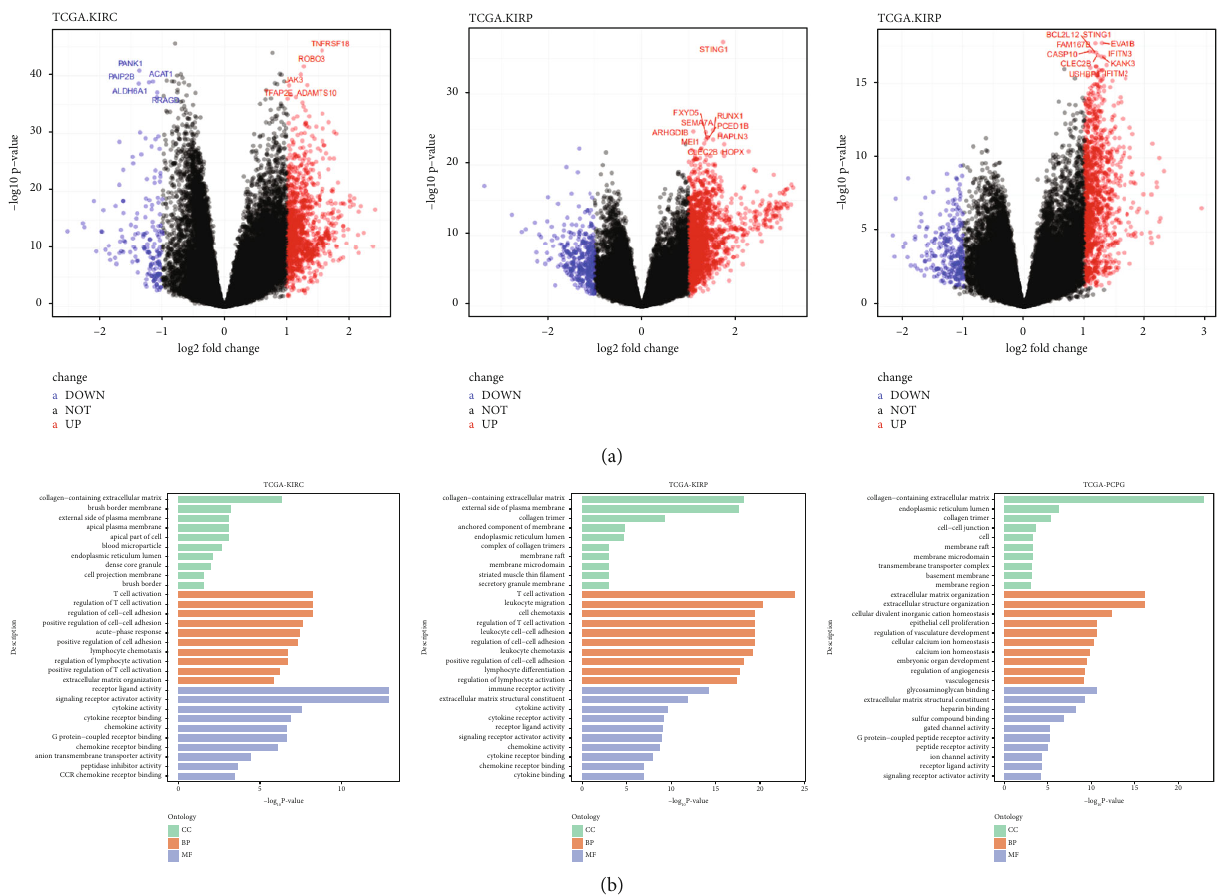
Figure 4: Alterations related to the cGAS-STING sensor in KIRC, KIRP, and PCPG. (a) Volcano plots displayed the di ff erentially expressed genes between tumors with higher cGAS-STING score and tumors with the lower cGAS-STING score; the median value was set as a cuto ff . (b) Gene Ontology analysis of di ff erentially expressed genes was performed in KIRC, KIRP, and PCPG, factor ( HR = 4 : 1 + e 06 , 95% CI 1 : 8 + e 06 − 9 : 5 + e 08 , P <